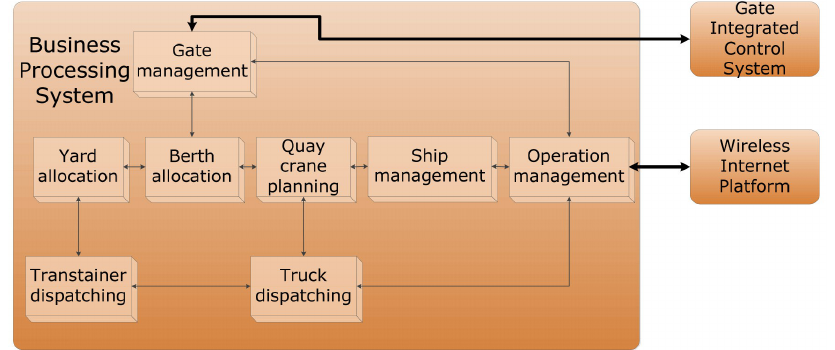
Figure 4. Business processing